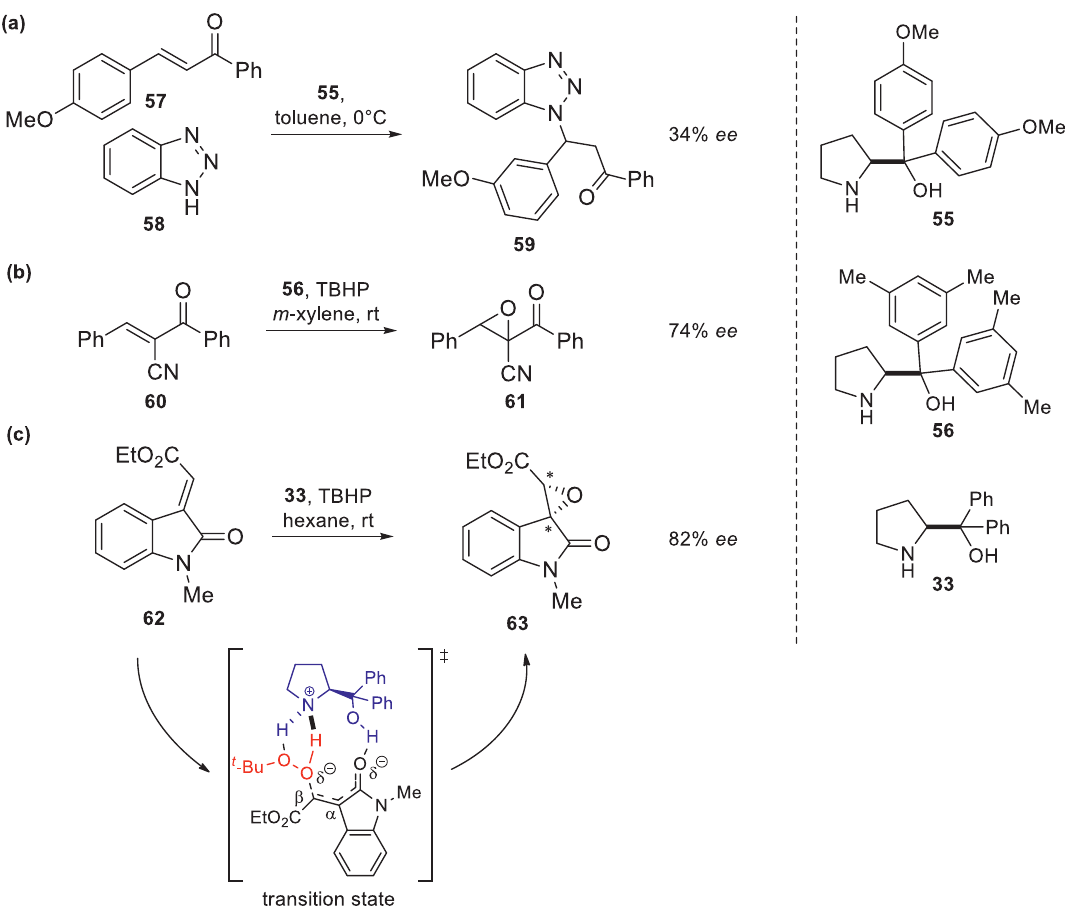
Figure 14 . Enantioselective conjugate addition of N -heterocycles to α , β -enones: (a), from Ref. [60]; epoxidation of acrylonitriles (b), from Ref. [63]; epoxidation of α -ylidenoxindoles (c), from Ref.